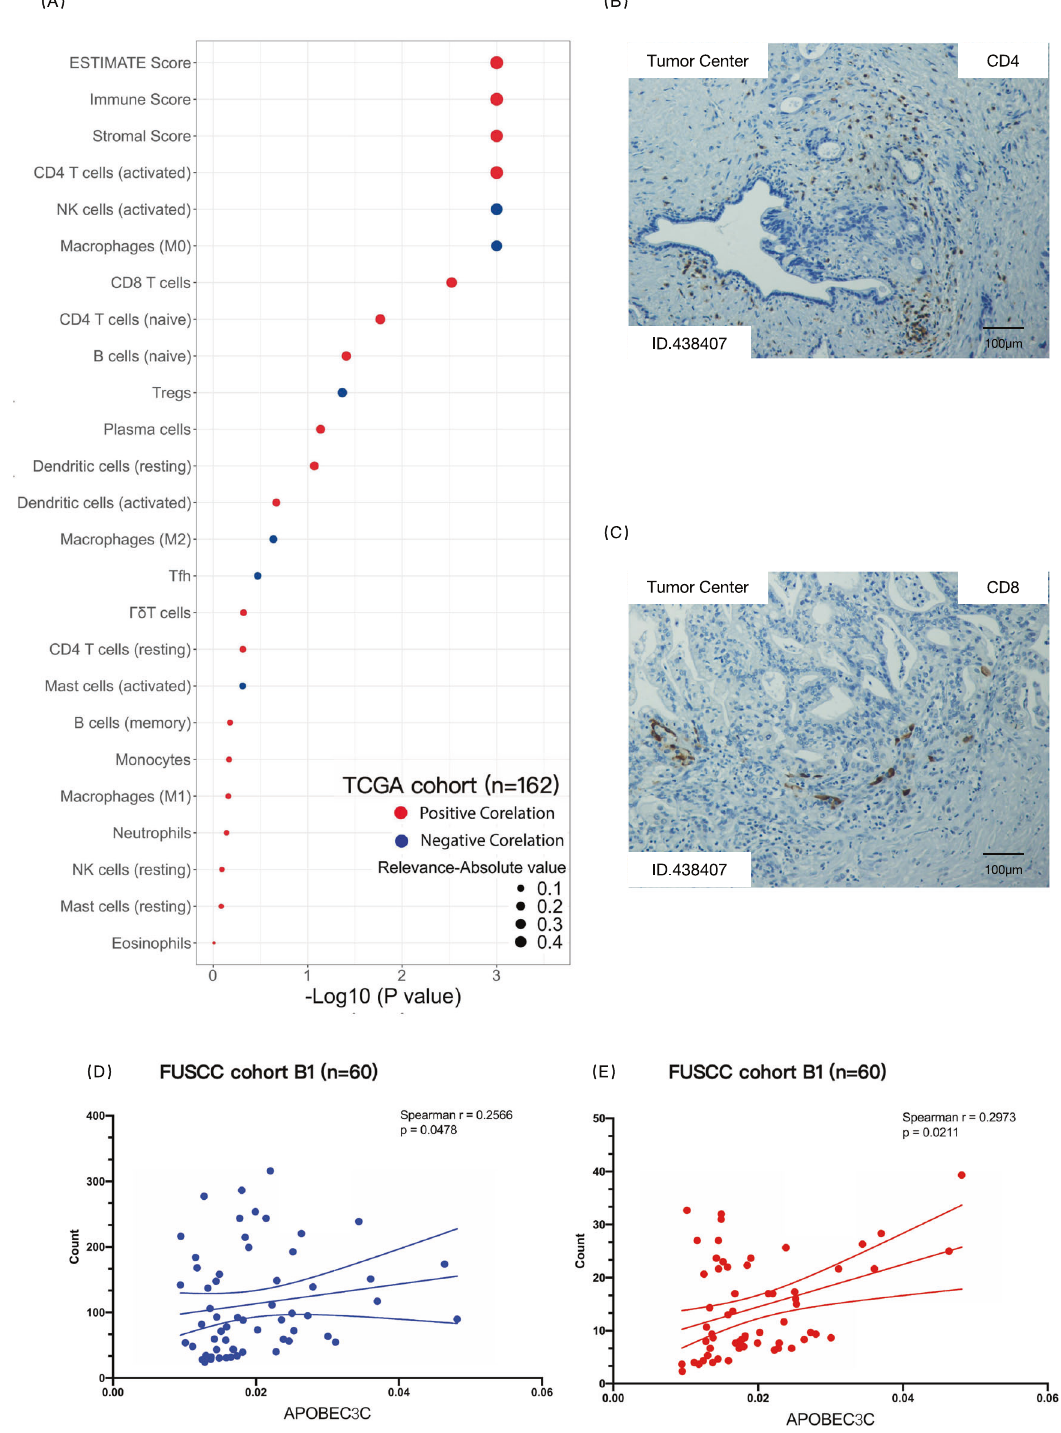
Fig. 6 APOBEC3C expression in PDAC correlates with TME remodelling. A ssGSEA was used to analyse the stroma of TCGA PDAC samples ( n = 162) and output the immune score and the stromal score. The immune score and the stromal score were integrated into the ESTIMATE score. The CIBERSORT analytical tool was used to estimate the fractions of 22 types of immune cells in the matrix of TCGA PDAC dataset (based on the characteristic gene signature fi le “ LM22 ” ). Spearman ’ s rank correlation coef fi cient was calculated to measure the correlation between APOBEC3C expression and leucocyte fractions in the PDAC TME. B , C Representative images showing CD4 IHC staining ( B ) and CD8 IHC staining ( C ) in FUSCC cohort B1 ( n = 60). For each sample, immune cells were manually counted in three representative high-power fi elds. D , E Nonparametric Spearman ’ s correlation test to determine whether the count of CD4 T cells ( D ) or the count of CD8 T cells ( E ) correlated with APOBEC3C expression in FUSCC cohort B1 ( n = 60). The APOBEC3C expression level was quanti fi ed using qRT – PCR. The immune cells were counted manually, and taken the mean values of three high-power fi elds (20×). PDAC, pancreatic ductal adenocarcinoma; ssGSEA, single-sample gene set enrichment analysis; NK cells, natural killer cells; Tfh, follicular helper T cells; Tregs, regulatory T cells; r ,